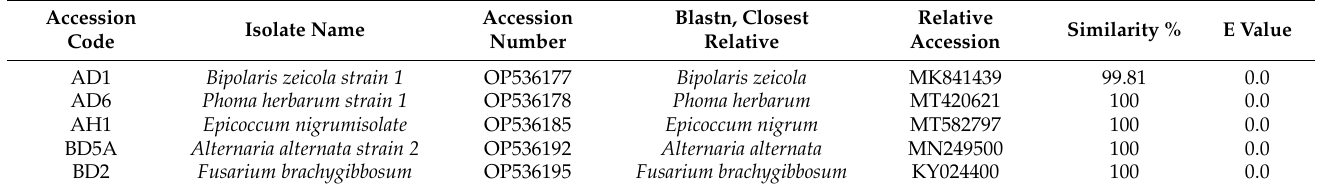
Table 1. 16 s rRNA gene sequence-based identification of the isolates and their accession